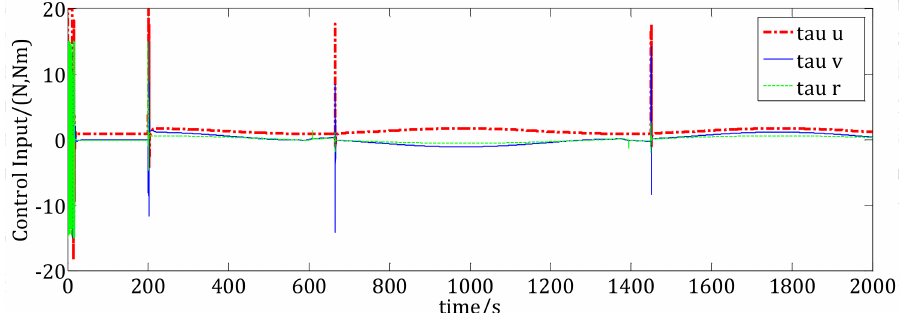
Figure 11. Control inputs of the USV under the traditional RC method.